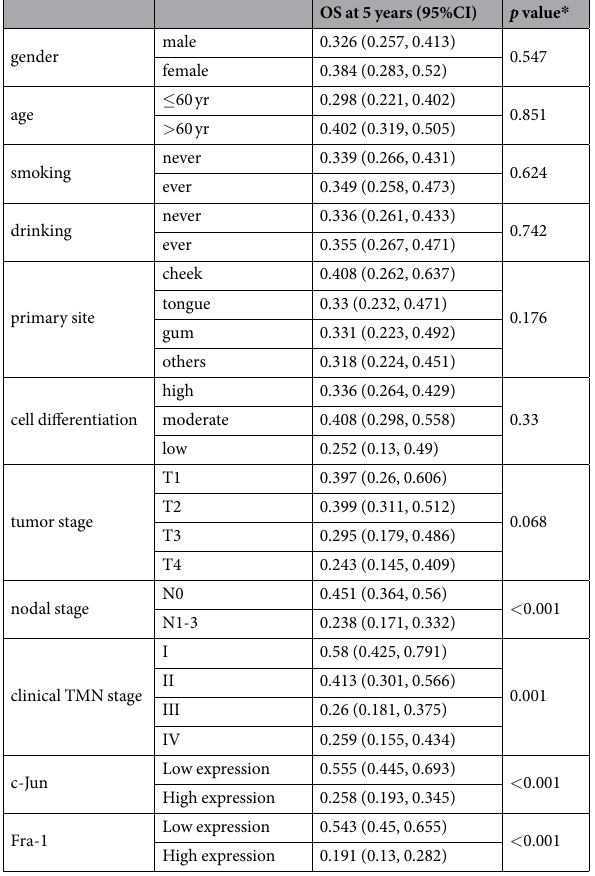
Table 2. The Overall Survival (OS) at 5 years in each subgroup population with OSCC. * p value was generated using log-rank